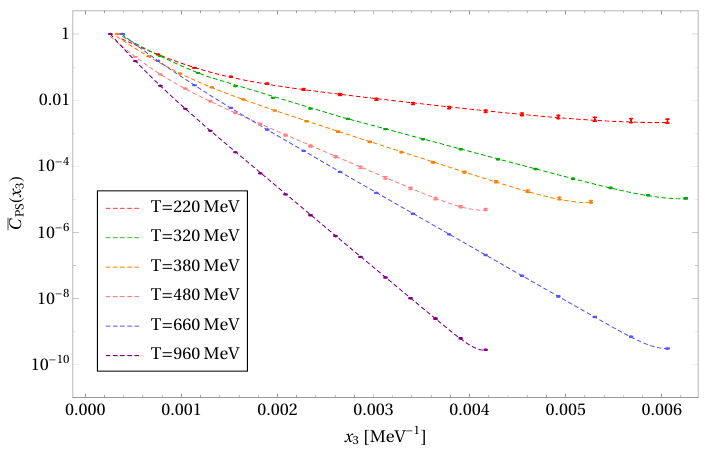
Figure 1 . Spatial pseudo-scalar lattice correlators obtained with N f = 2 domain wall fermions in [45]. The dashed lines represent fits to the data using the ansatz in eq. (3.5). The corresponding χ 2 / d.o.f. of the fits are listed in table